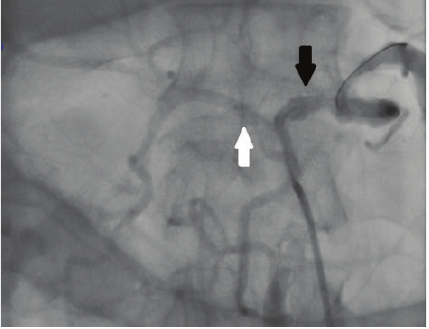
Figure 5: Postprocedure angiography showing good flow in HA (white arrow) and SA (black